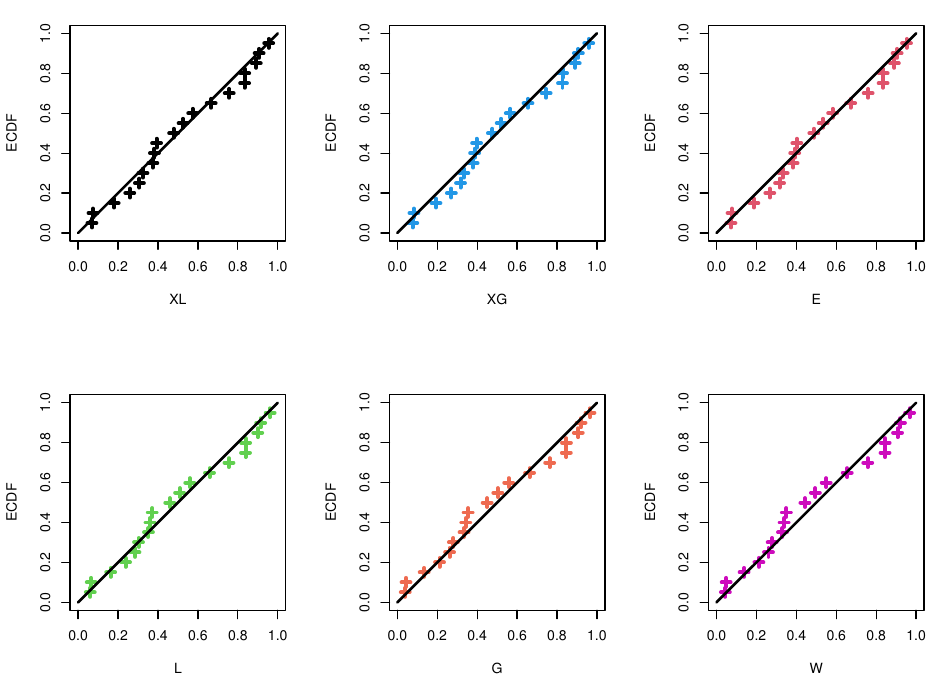
Figure 9. The QQ plots of the XL and competing models from SSB